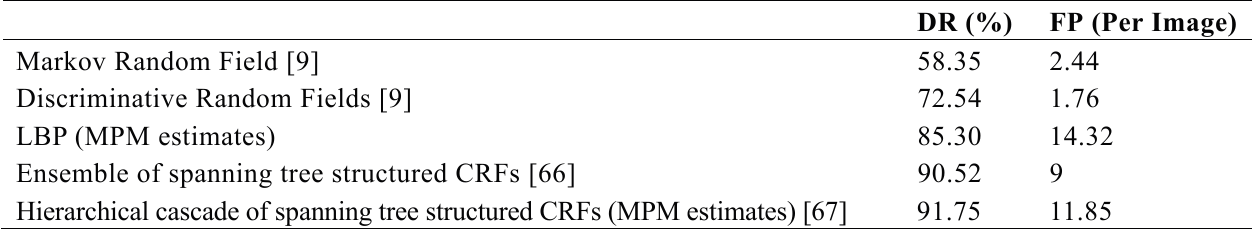
Figure 4. Example results for structure detection task. True positives are brightened and outlined with white boundaries. Table 1. Detection rates (DR) and false positives per image (FP) for structure detection problem over the test set containing 129 images. Comparisons to Markov random field, and grid-structured CRF model with loopy belief propagation inference (LBP) are also